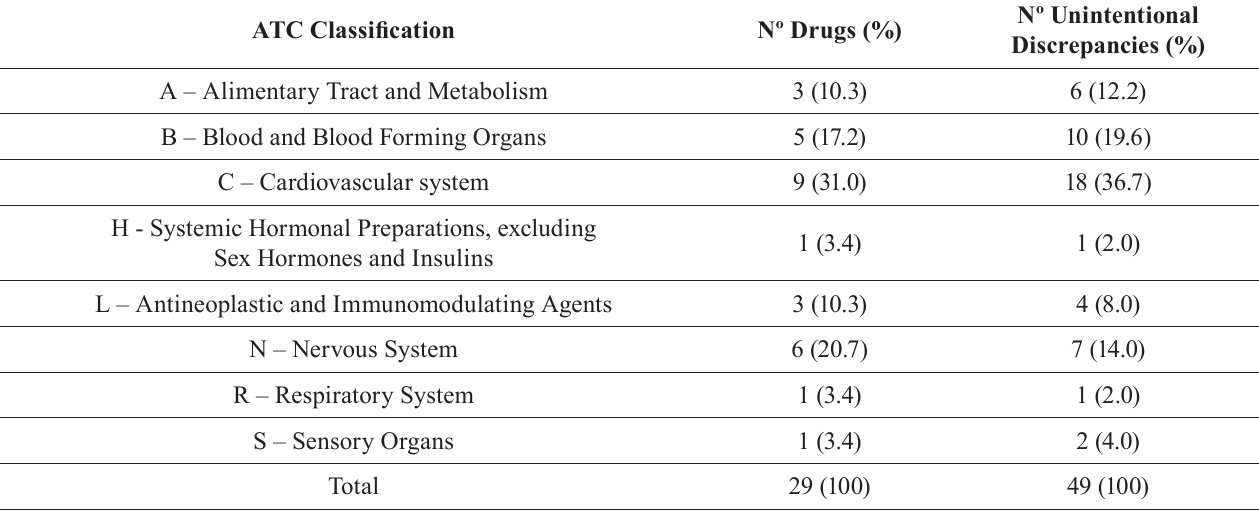
TABLE III - ATC classification*of medications in unintentional discrepancies